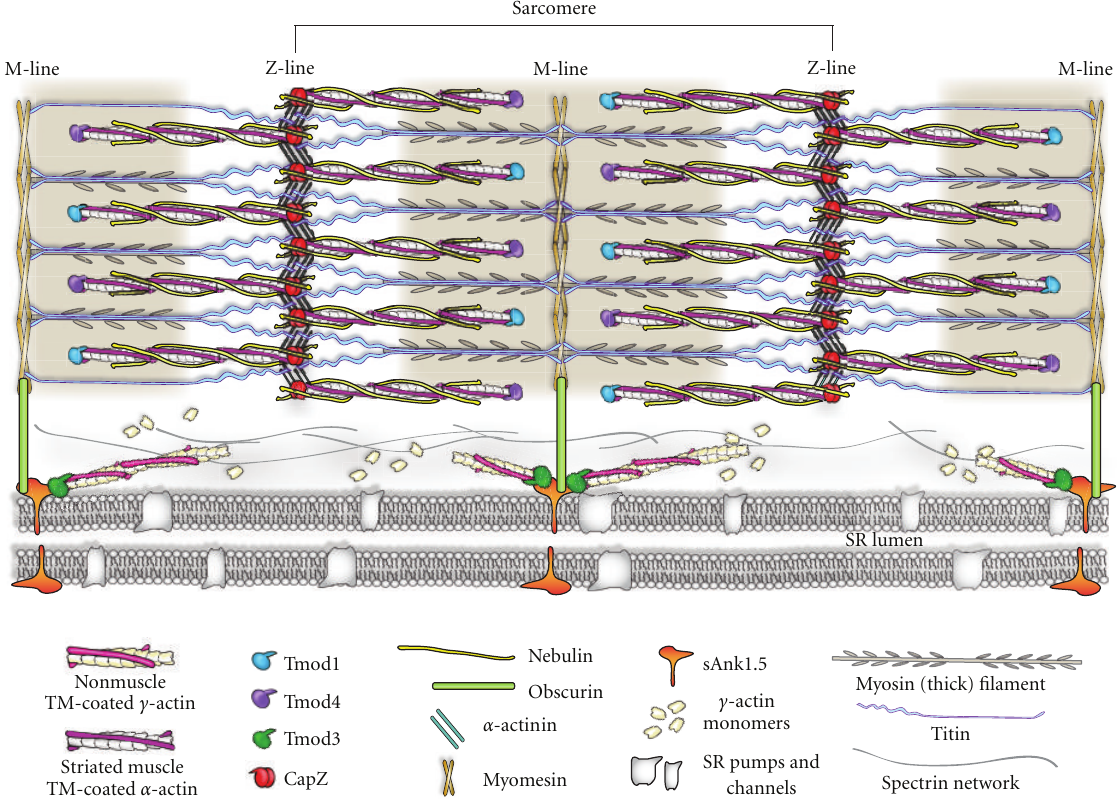
Figure 3: Model diagram of Tmods in the sarcomeres and SR of skeletal muscle. Thin filaments, consisting of α -actin subunits, are capped at their pointed ends by a combination of Tmod1 and Tmod4 in skeletal muscle, whereas Tmod3 is associated with cytoplasmic (nonmuscle) γ -actin filaments in the SR. The exact stoichiometries and distributions of Tmod1 versus Tmod4 on the thin filament pointed ends are unknown. Tmod-capped thin filaments extend past the distal N-terminus of nebulin into the middle of the sarcomere. By contrast, in cardiac muscle (not shown here), thin filament pointed ends are capped solely by Tmod1 and do not contain nebulin. Filaments composed of γ -actin, nonmuscle TMs, and Tmod3 are anchored to the SR membrane via sAnk1.5 and laterally connected by a spectrin network. Tmod3/nonmuscle TM/ γ -actin filaments are connected to myofibrils via Tmod3 binding to sAnk1.5, which links to obscurin, which, in turn, is linked to myomesin and titin at the M-line. To date, Tmod3’s localization with respect to the cardiac SR remains undetermined. Note that for clarity, the thick filaments are not drawn to scale with respect to the thin